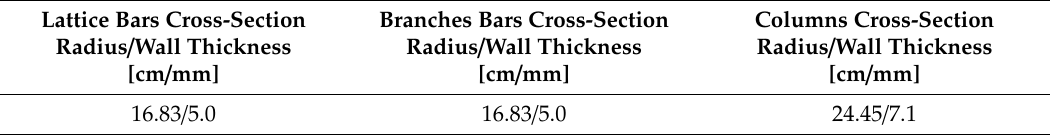
Table 1. Division of the structures’ bars and their cross